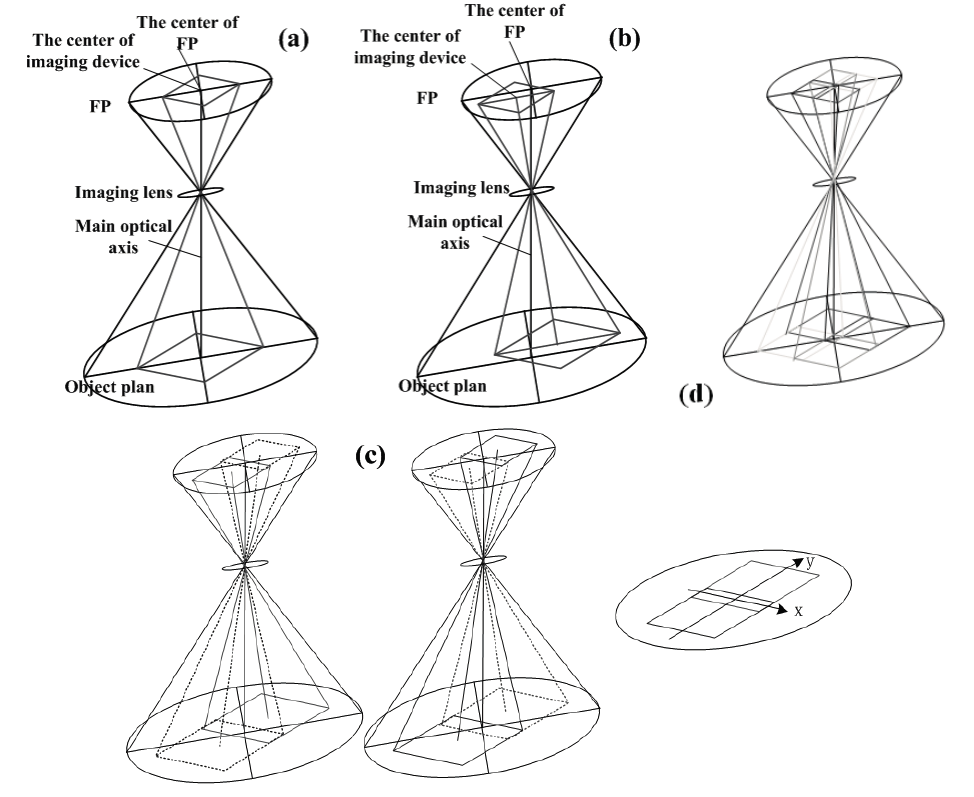
Figure 3. Intuitive representation of the imaging mode and novel MDCS: ( a ) traditional imaging mode; ( b ) tilt-shift imaging mode; and ( c , d ) novel MDCS, which include two or four chip CCD